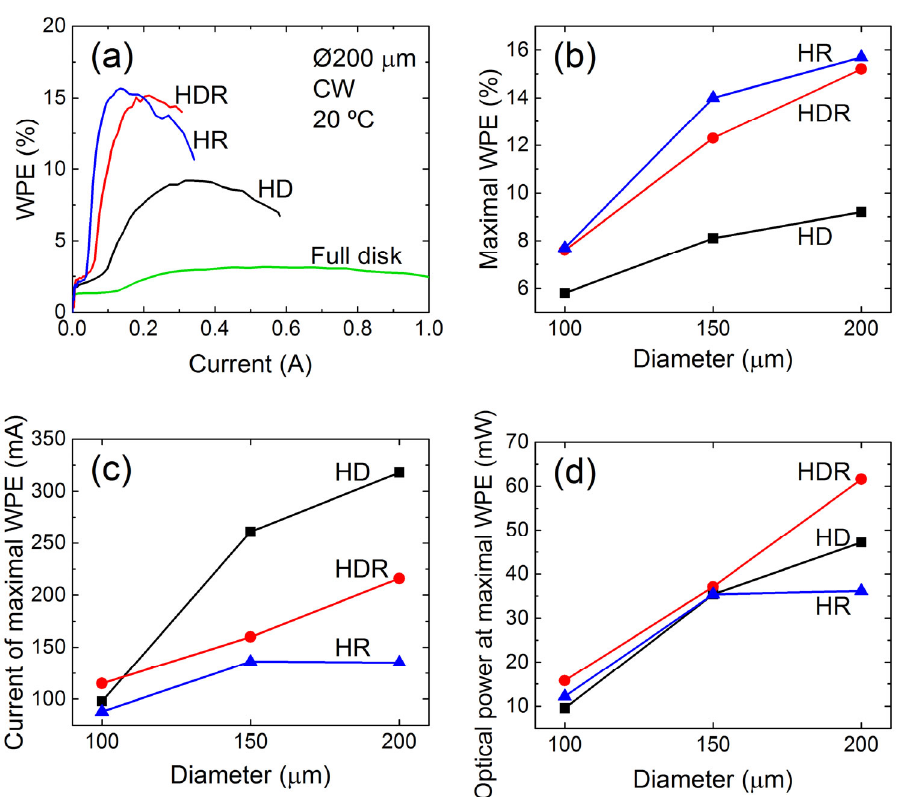
Figure 3. The wall-plug efficiency (WPE) versus the injection current ( a ), maximal WPE ( b ), currents at which maximal WPE is achieved ( c ) and optical powers corresponding to maximal WPE ( d ) of HDs, HDRs and HRs of various diameters. Panel ( a ) also presents data for a Ø200 μ m full disk with round contact for comparison. Data correspond to 20 ◦ C CW measurements of p-side-up mounted devices; the WPE corresponds to the optical power received by photodiode.